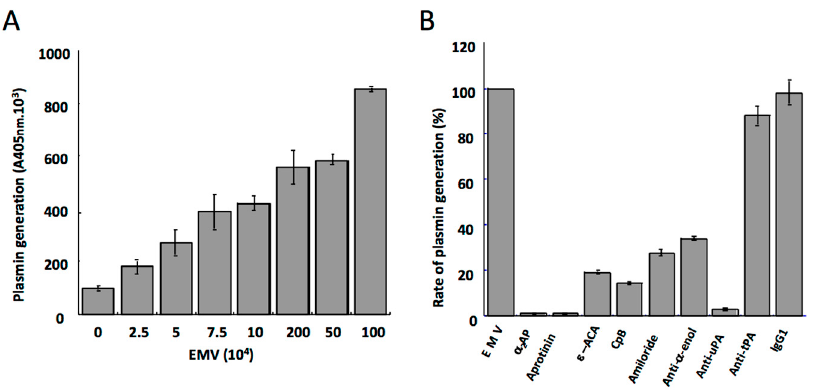
Figure 5. Plasmin generation on membrane microvesicles derived from the human microvascular endothelial cell line HMEC-1. ( A ) Varying concentrations of endothelial microvesicles (EMV) were incubated with a fixed amount of plasminogen. Plasmin generation was detected with a chromogenic substrate. The amount of plasmin formed is a function of the concentration of microvesicles, i.e., of the amount of plasminogen activator (uPA) present at their membrane. ( B ) The specificity and characteristics of the activation of plasminogen at the microvesicle surface. Plasmin formed on the endothelial microvesicles is inhibited by a 2 -antiplasmin ( α 2 -AP) and aprotinin. Binding and activation of plasminogen on endothelial microvesicles is prevented by the lysine analogue ε -aminocaproic acid ( ε -ACA), carboxypeptidase B (CpB), and an anti- α -enolase (anti- α -enol) polyclonal antibody. The activity of uPA on the microvesicles is inhibited by amiloride and a specific polyclonal antibody anti-uPA, whereas an antibody anti-tPA or non-immune IgG has no effect [29].